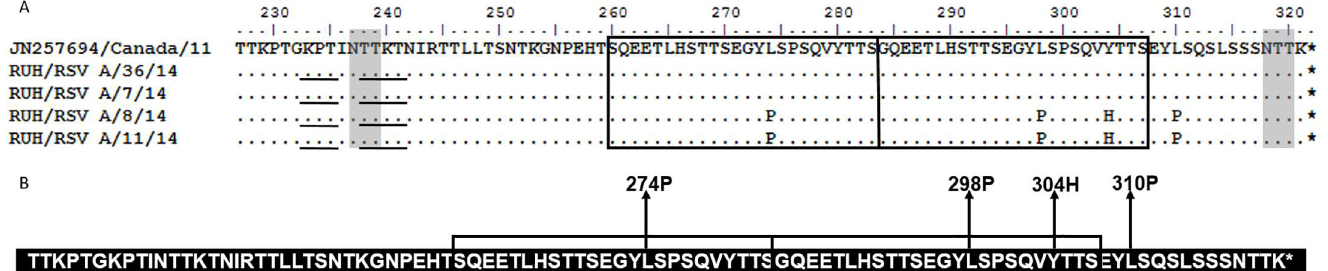
Fig 3. (A) Deduced amino acid alignment and mutations in the second variable region of G protein of the ON1 genotype. The figure includes alignment of study ON1 strains with the prototypestrain from Canada(JN257694). The amino acids sequencealignmentcorresponds to 227–321amino acids of the prototypestrain. Identical residuesare indicatedby dashes. The two copies of the duplicated24-amino-acid regionin group ON1 strains are indicatedby rectangular boxes. Stop codons are indicatedby asterisks. Potential N-glycosylation sites (NXT, where X is not proline) are indicatedby grey shading. The potential sites for extensive O-glycosylation KPX - - - TTKX motifs are underlined. (B) The amino acid sequence of ON1 genotype showing mutations in the study strains. The sequencecorresponds to the 227–321 amino acids of the ON1 prototype strain. The rectangular boxes represent the analogous24 amino acid regionfollowedby duplicated 24 amino acid regionin ON1 strains. Changesat amino acid positionsin study strains are shown by